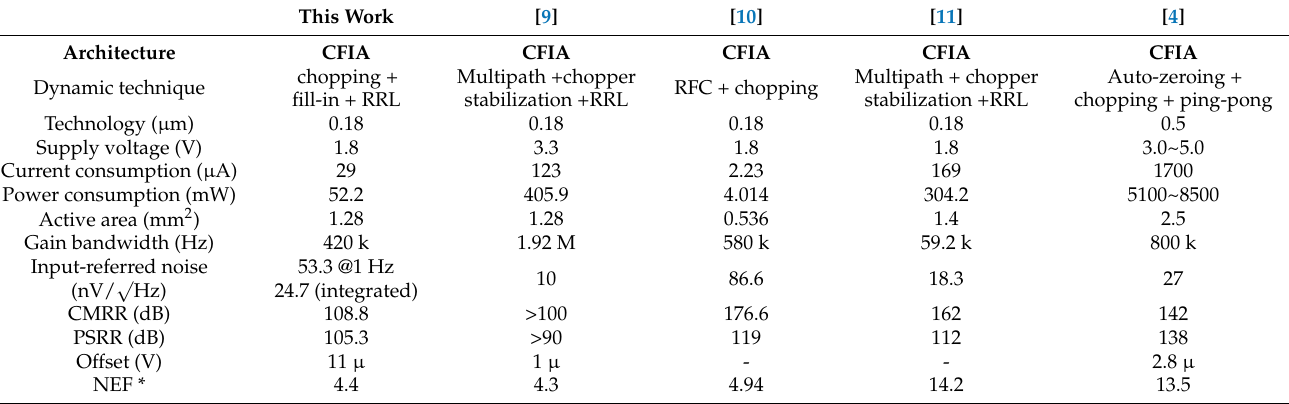
Table 6. Performance summary of the proposed CFIA and comparison with other